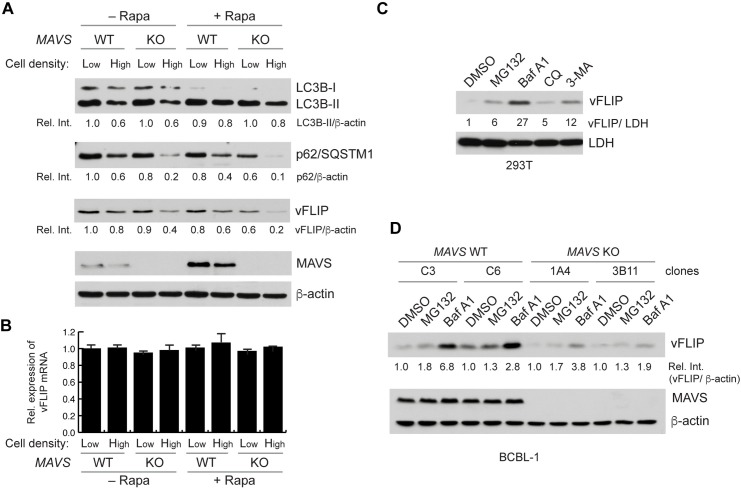
Autophagy-induced vFLIP degradation.(A) Immunoblots of LC3B, p62, vFLIP, MAVS, and β-actin from WT and MAVS KO BCBL-1 cells cultured at low (seeded at 5 x 104 cells/ml) and high (seeded at 2 x 105 cells/ml) densities in the presence and absence of 20 nM rapamycin for 2 days. Relative band intensities normalized by β-actin were calculated and noted below each panel. (B) Real-time quantitative PCR (RT-qPCR) analysis of vFLIP mRNA from the cells cultured as in (A). Data are represented as mean ± SD of triplicate. (C) Immunoblots of vFLIP and loading control lactate dehydrogenase (LDH) from vFLIP-transfected 293T treated with 10 μM MG132, 100 nM bafilomycin A1 (Baf A1), 5 μM chloroquine (CQ), and 5 mM 3-methyladenine (3-MA) for 1 day. Relative vFLIP intensities normalized by LDH are shown below each panel. (D) Immunoblots of vFLIP, MAVS, and loading control β-actin from WT and MAVS KO BCBL-1 cell lines cultured at high density for 2 days and then treated with 20 nM Baf A1 and 10 μM MG-132 for 8 h. Relative vFLIP intensities normalized by β-actin are shown below each panel.